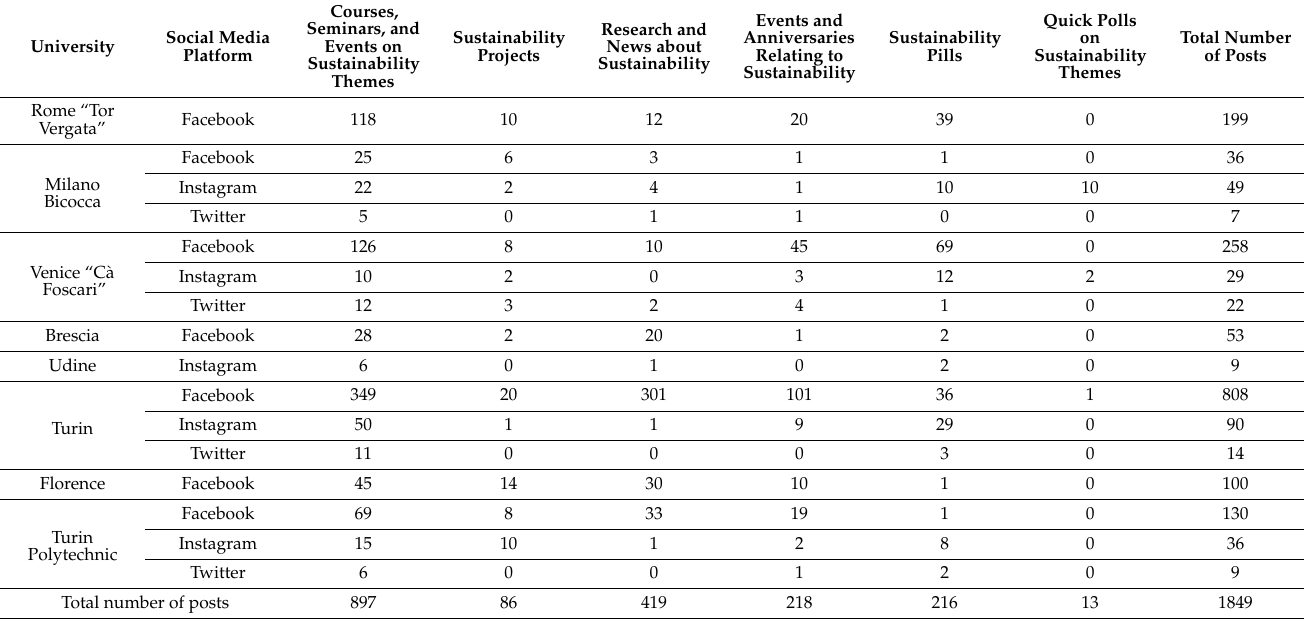
Table 3. Number of posts per topic belonging to “social media for educating”